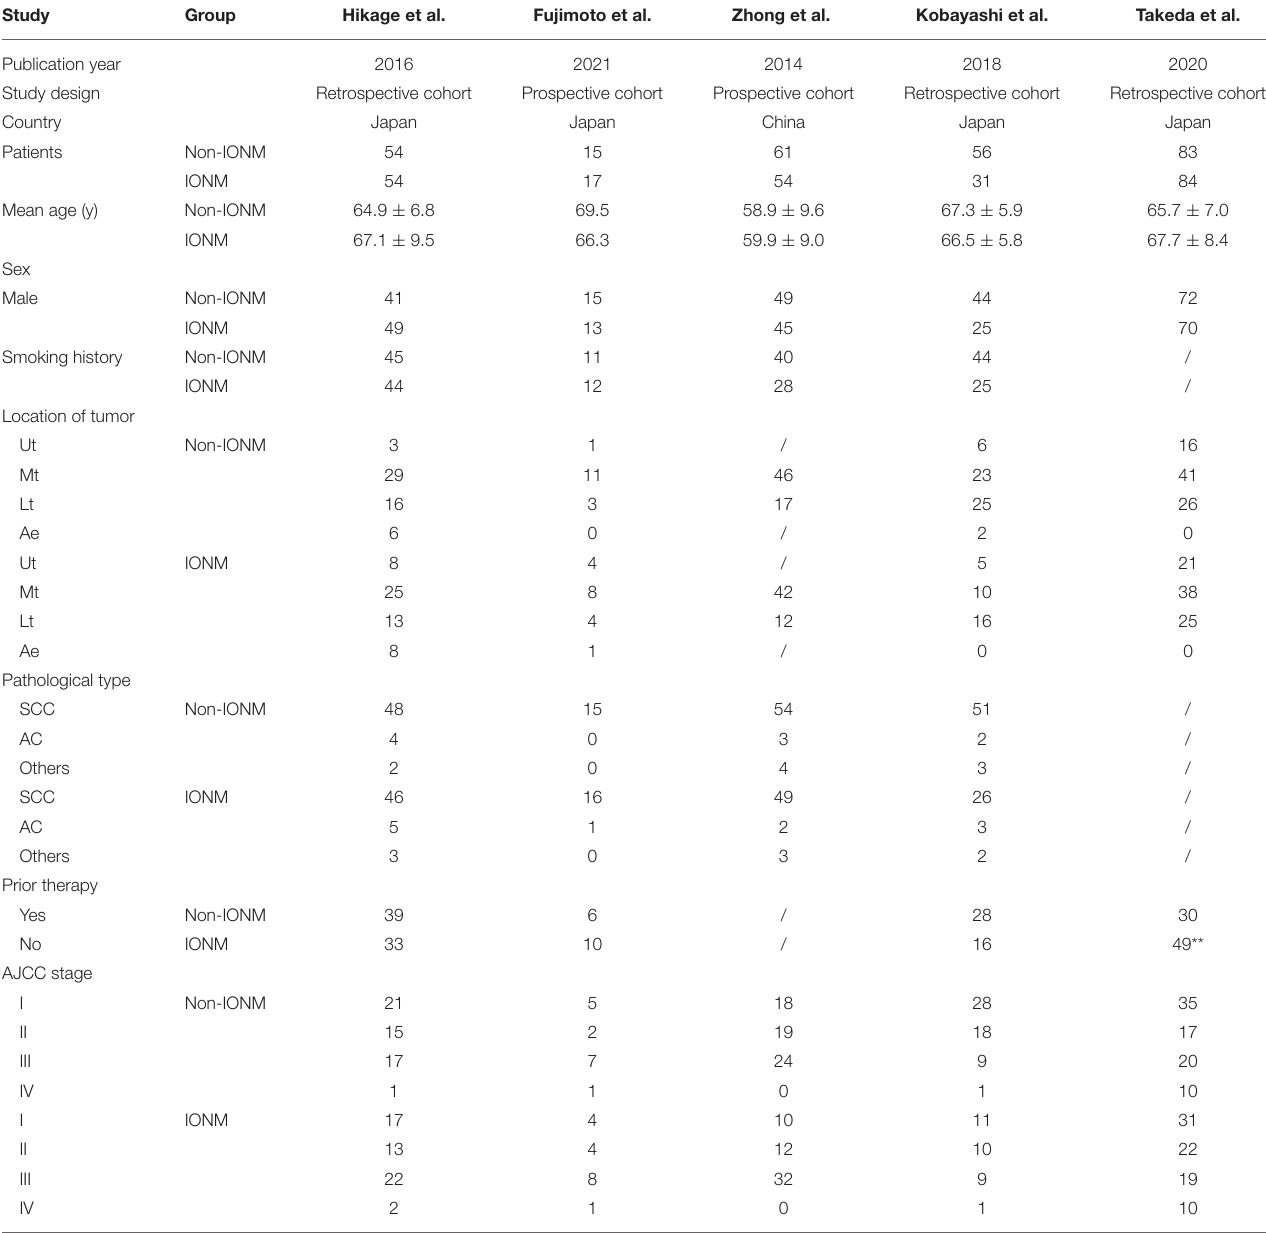
TABLE 1 | Baseline characteristics of